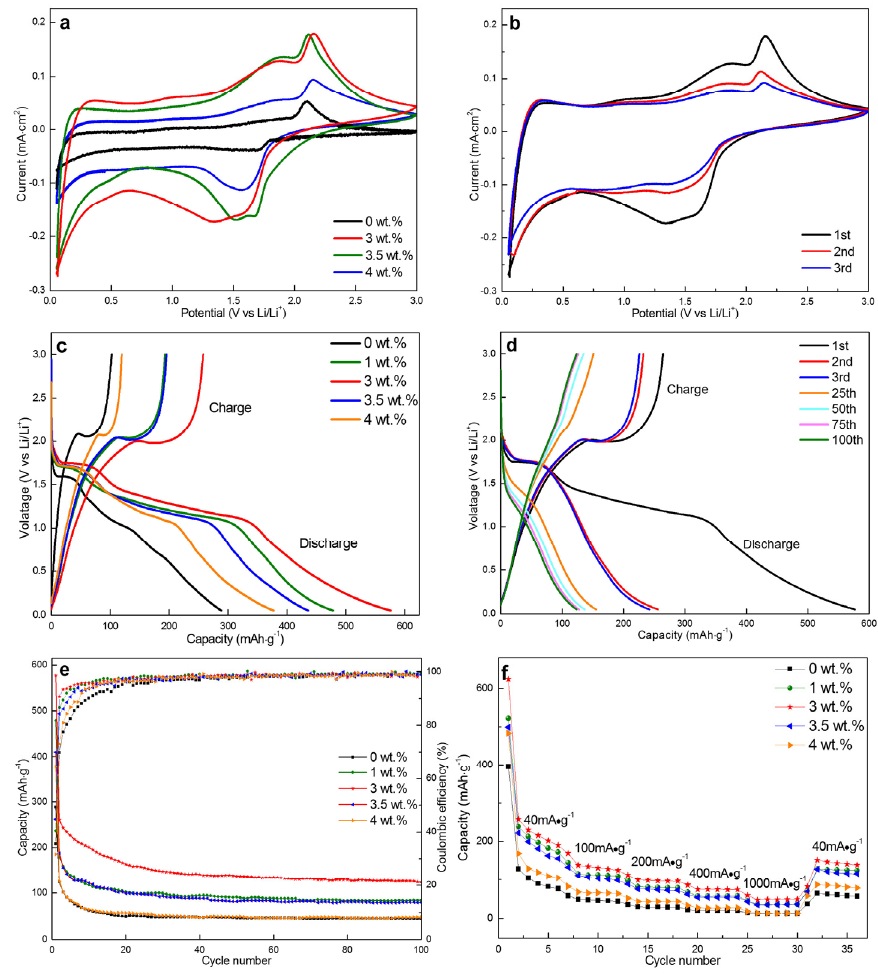
Figure 10. Cyclic voltammograms of ( a ) Ni-doped TiO 2 nanofibers and ( b ) 3 wt.% Ni-doped TiO 2 nanofibers from the first three cycles at a scan rate of 0.2 mV / s between 0-3 V. First charge-discharge curves of ( c ) Ni-doped TiO 2 nanofibers and the first three charge-discharge curves of ( d ) 3 wt.% Ni-doped TiO 2 nanofibers at 100mA · g − 1 . ( e ) Cycle performance and coulombic e ffi ciency of Ni-doped TiO 2 nanofibers at 100 mA · g − 1 . ( f ) Rate capability of Ni-doped TiO 2 nanofibers at di ff erent current densities.